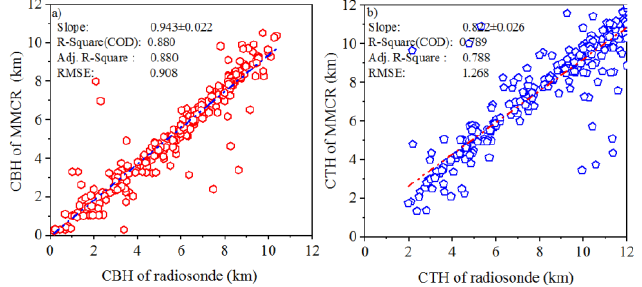
Figure 14. Adj. R-square of CBHs and CTHs detected by the radiosonde and MMCR from December 2020 to November 2021. ( a ) The blue dotted line shows the fitted line of CBHs detected by the radiosonde and MMCR, and ( b ) the red dotted line is the fitted line of CTHs detected by the radiosonde and MMCR. In the figures, the R-square (COD) is the determination coefficient, the adj. R-square is the determination coefficient of the modified degree of freedom, and the RMSE is the root mean square error. The expression of the adj. R-square can be written as 𝑅 2 (𝑎𝑑𝑗) = 1 − (1 − 𝑅 2 ) ∙ (𝑛 − 1) (𝑛 − 𝑃 − 1) ⁄ , where P is the number of variables, n is the number of samples, and R means R-squared .